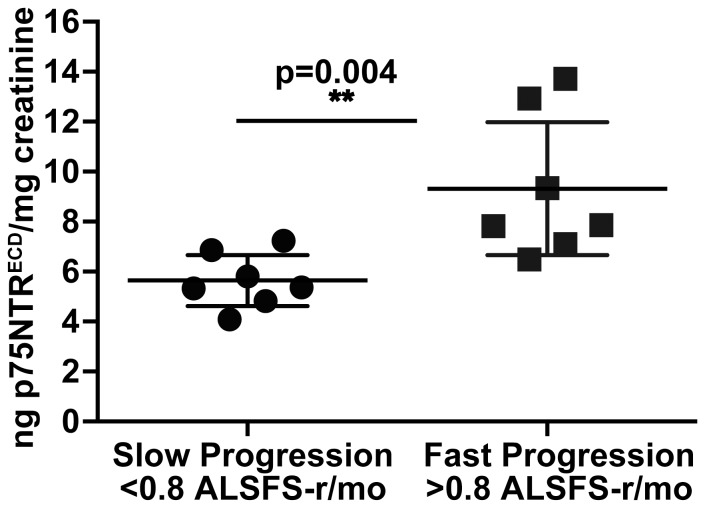
There are significant amounts of p75NTRECD in the urine of rapidly progressing compared to slowly progressing ALS patients.Scatter plots show urinary p75NTRECD concentrations in ‘slowly progressive ALS’ (n = 7) and ‘rapidly progressive ALS’ (n = 7). The horizontal lines represent the mean, with 95% confidence interval. Progression rate is decline in ALSFRS-r per month. *Mann–Whitney test (p = 0.004).